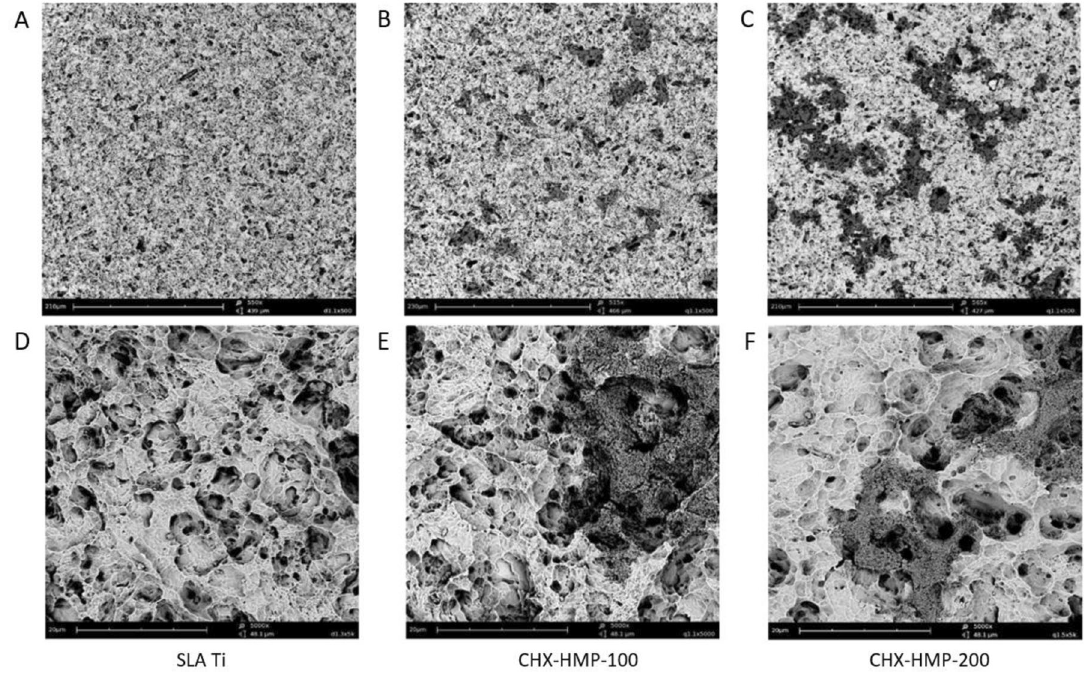
Fig. 1 Representative SEM micrographs of A , D SLA Ti, B , E CHX-HMP-100, and C , F CHX-HMP-200 coatings showing number and distribution of CHX-HMP deposits. Scale bars 210 µm ( A – C ) and 20 µm ( D – F